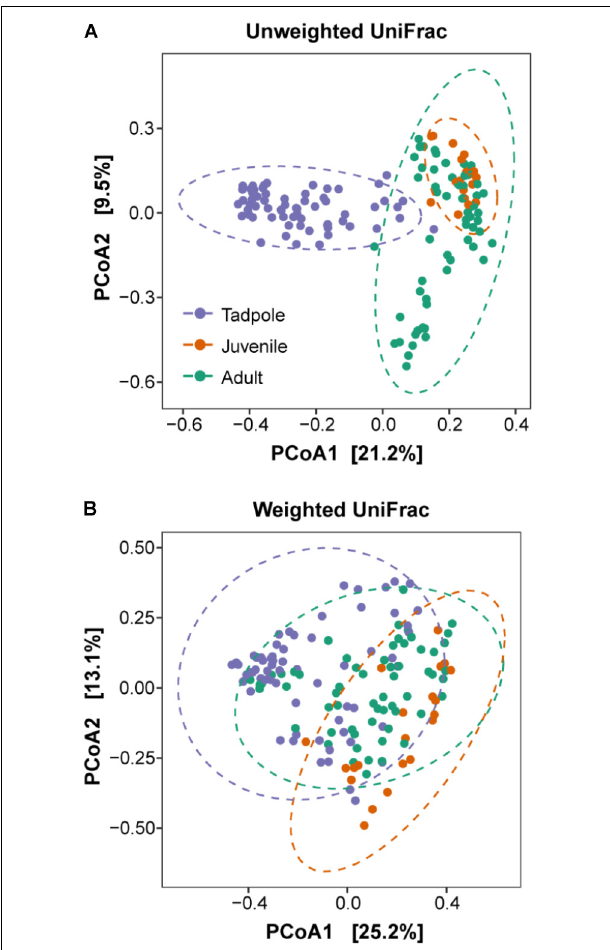
FIGURE 4 | Principal coordinate plots (PCoA) of beta diversity of the skin microbiome composition. (A) Unweighted UniFrac matrices and (B) Weighted UniFrac matrices of L. vibicarius across life stages. Ellipses show 95% confidence intervals (95% CIs) of each life stage. Each point represents the skin bacterial community of an individual